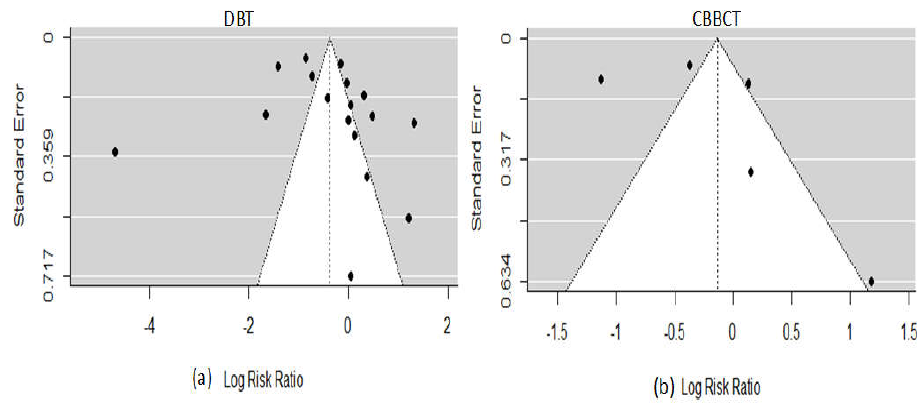
Figure 4. Funnel plots of the likelihood of bias in included studies. ( a ) DBT; ( b ) CBBCT.